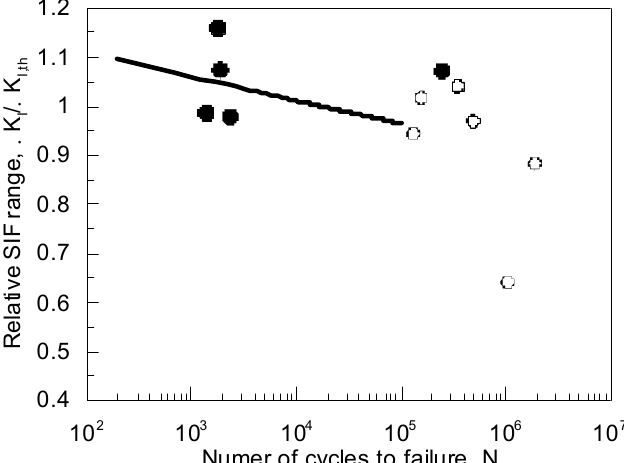
Figure 3: SN plot of fatigue results on notched specimens (open circles indicate run-out